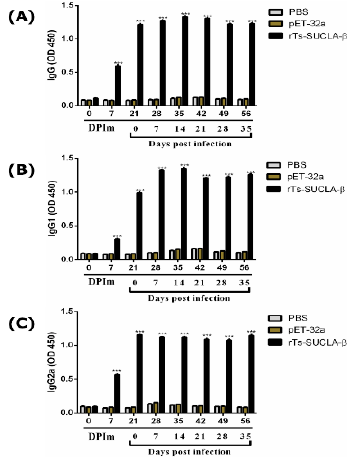
Figure 10. Detection of anti-rTs-SUCLA- β serum IgG by ELISA. ( A ) detection of IgG level. ( B ) Detection of IgG1 level. ( C ) Detection of IgG2a level. The values shown for each group are the mean standard error of the antibody levels ( n = 10). The numbers 0–56 are days post immunization and 0–35 are days post infection of T. spiralis . Significant di ff erences was marked with *** when p < 0.001.